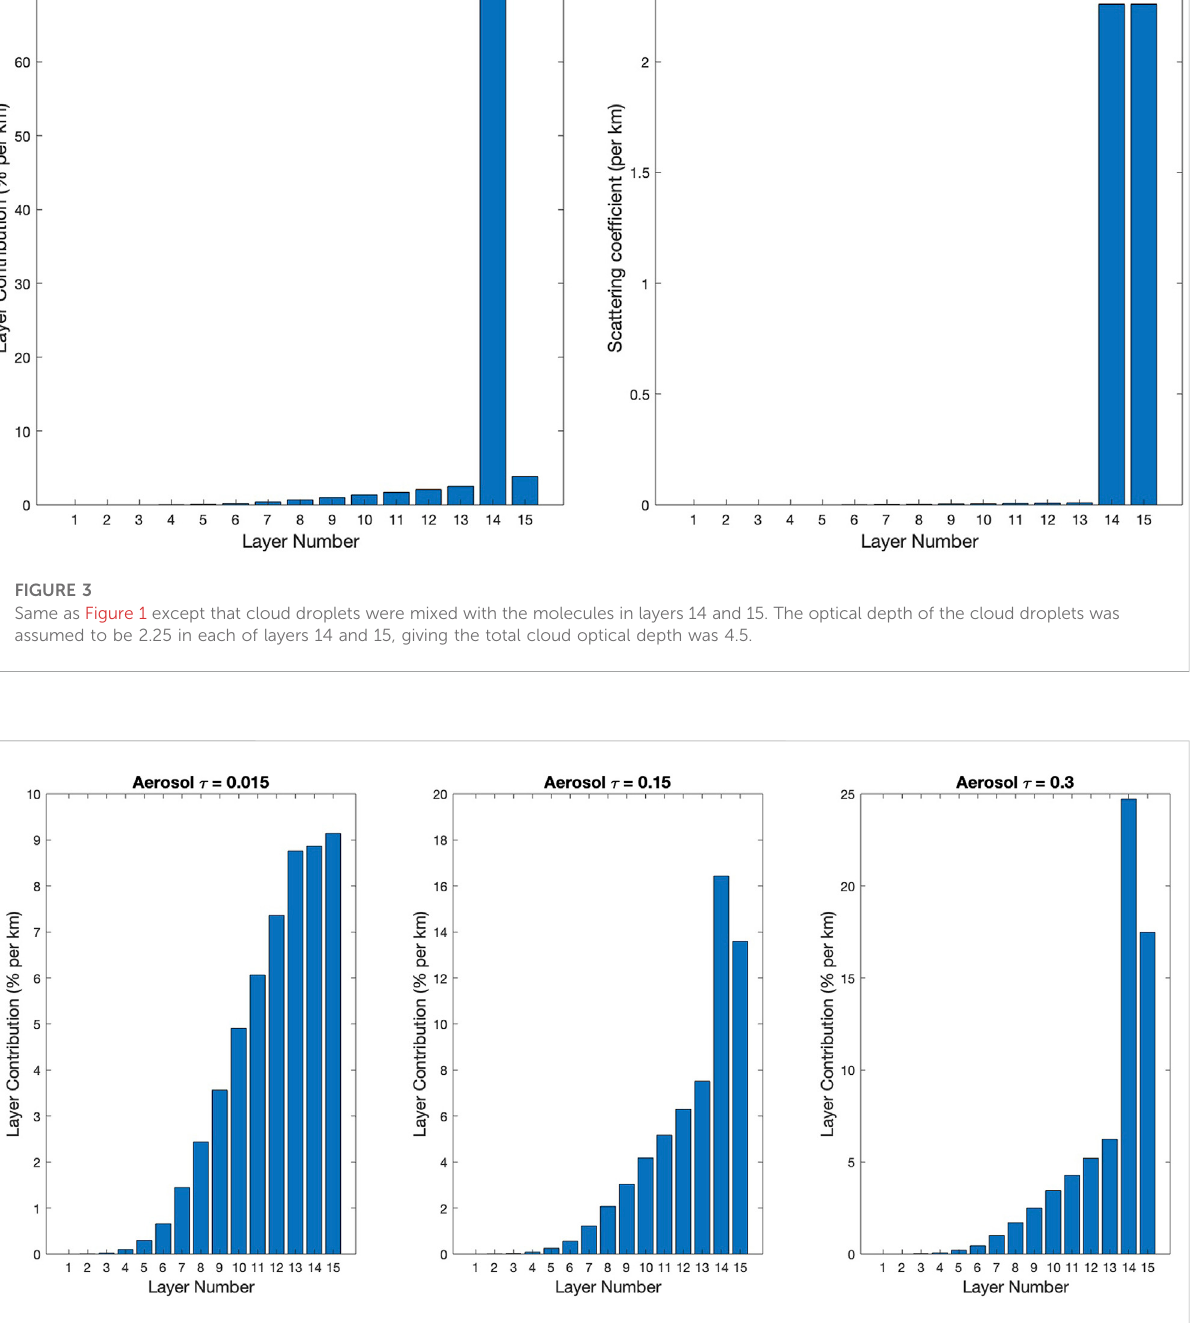
FIGURE 4 Left panel:Same as left panel of Figure 2 exceptthat the total AOD for layers 14 and 15 was decreased from 0.3 to 0.015. Middle panel: Same as left panel of Figure 2, but for a total AOD of 0.15 for layers 14 and 15. Right panel: Same as left panel of Figure 2 i.e. for a total AOD of 0.3 for layers 14 and